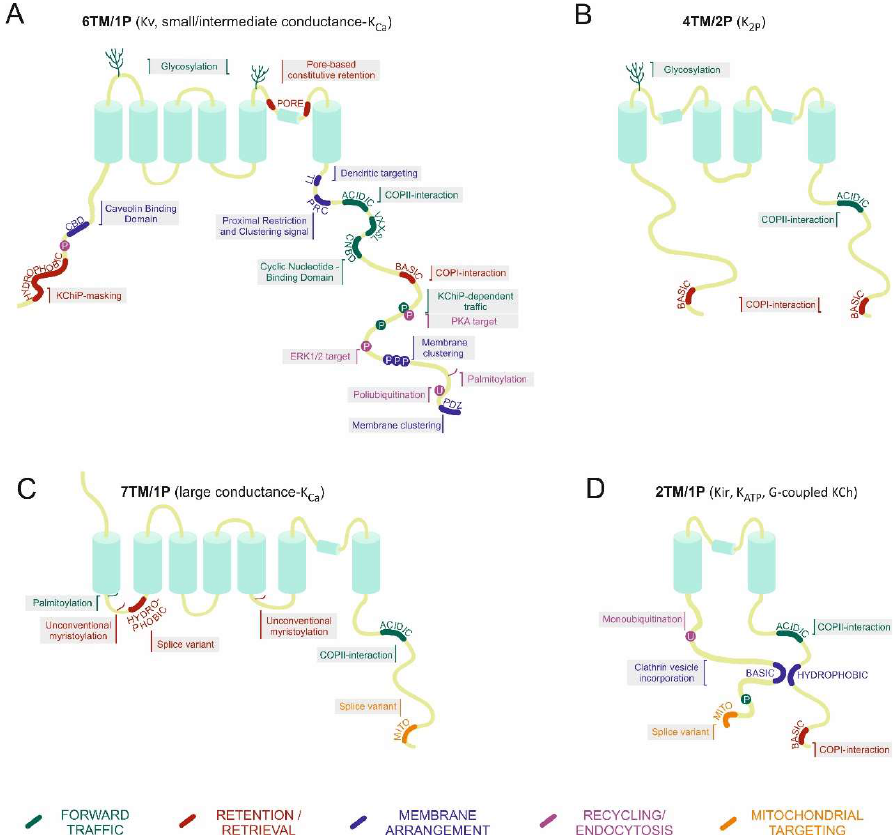
Figure 1. Traffic motifs and molecular interacting signatures within K + channel structures. A schematic representation of each family of potassium channels. ( A ) 6TM/1P; ( B ) 4TM/2P; ( C ) 7TM/1P; and ( D ) 2TM/1P. Structural domains and post-translational modifications (PTMs) affecting traffic and the destination of different channels in each family are shown. Cartoons represent a compilation of signatures documented in each structural family. It is important to highlight that not all signatures are present in the same channel. The color code corresponds to the main dominant effect in traffic. Green, forward traffic. Red, retention/retrieval domains. Blue, membrane arrangement. Magenta, channel recycling and endocytosis. Orange, mitochondrial targeting. Basic, cluster of basic residues; Acidic, cluster of acid residues; Hydrophobic, hydrophobic clusters; LL, di-leucine motif; P,